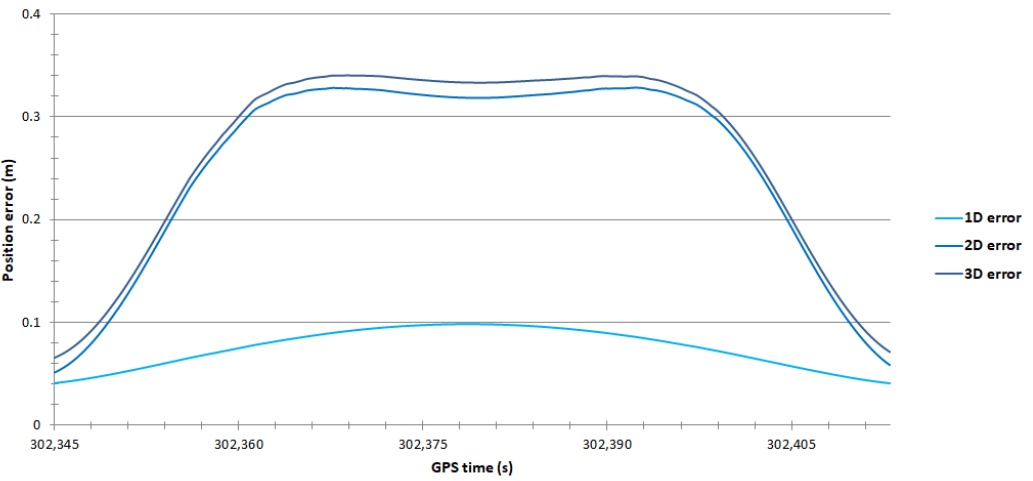
Figure 13. Variability in position errors recorded by the GNSS/INS system in the PP mode in section no. 3.